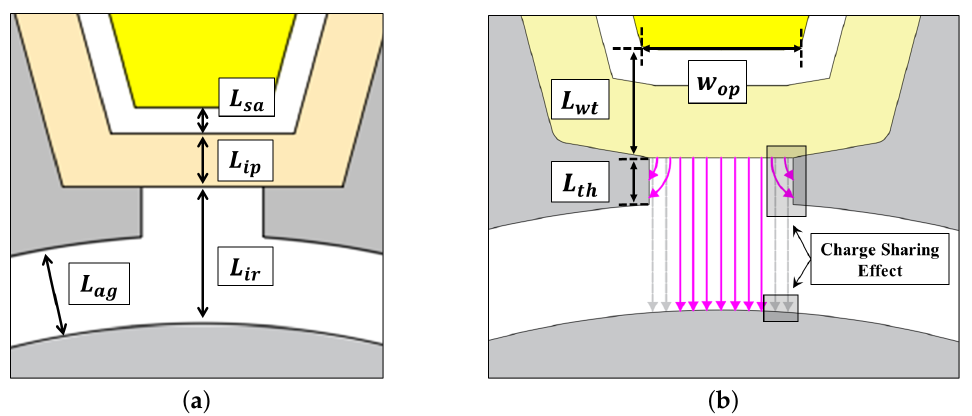
Figure 6. Design variables and charge sharing effect for winding-to-rotor capacitance ( a ) Design variables. ( b ) Charge sharing effect of the slot